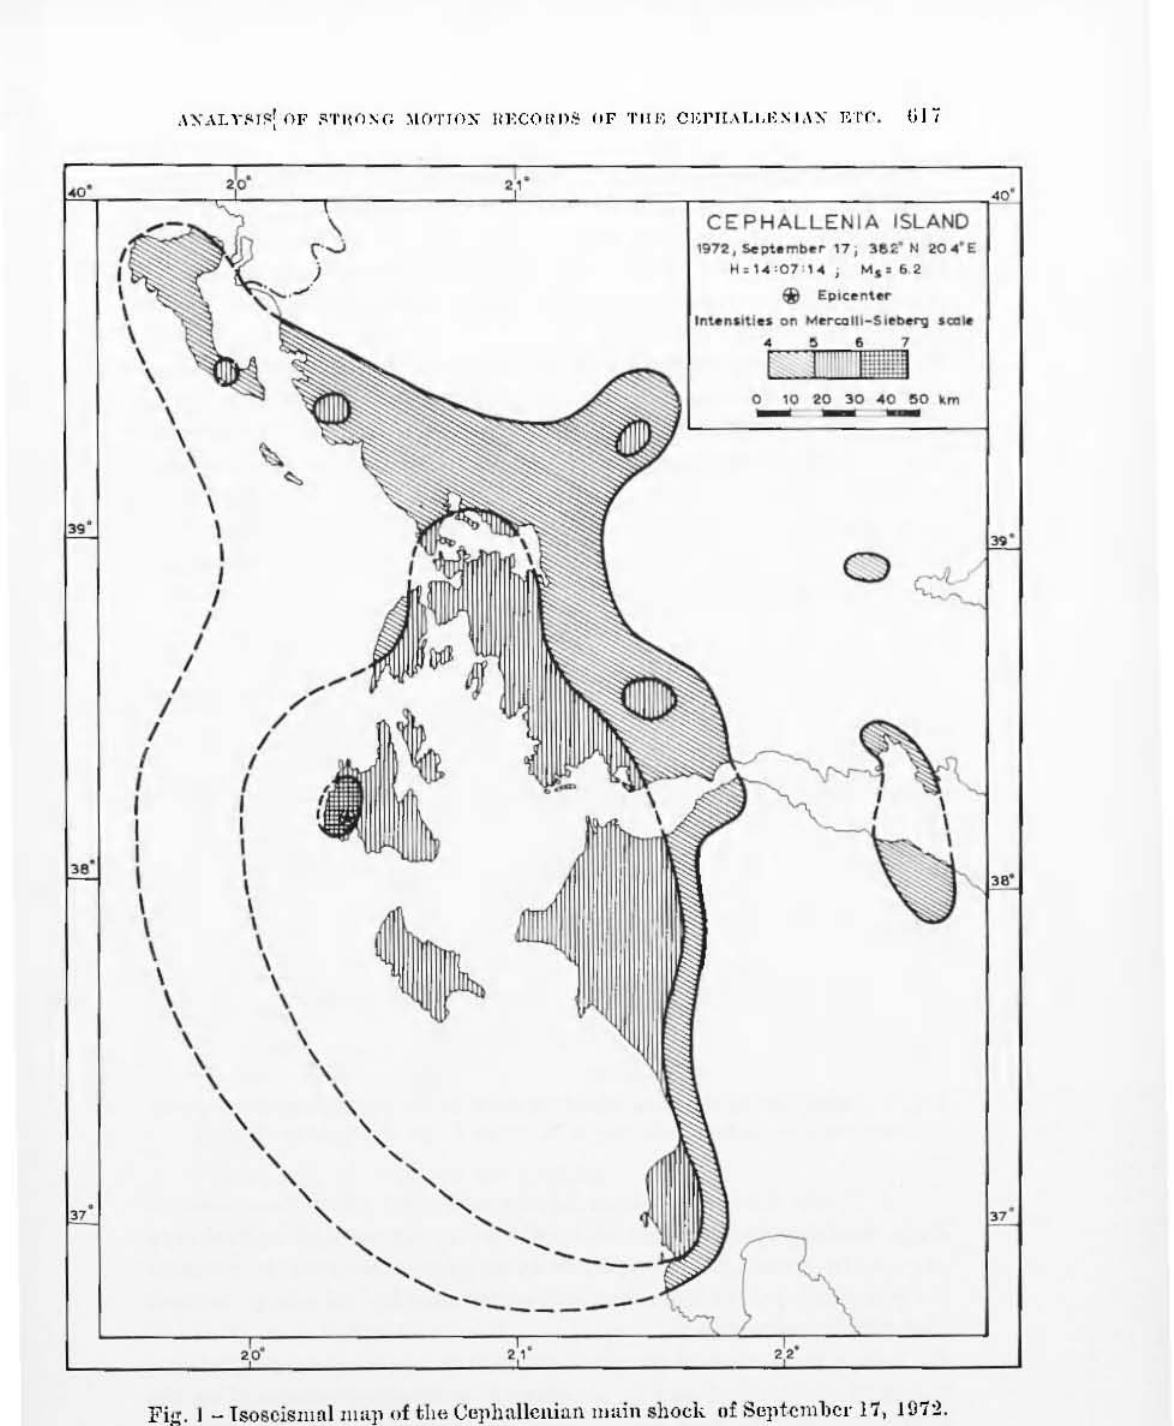
Fig:. I - lsoscismul map of thtl Cc]lhallcllian main shock Ili SIl]1k mllCr 17, 1